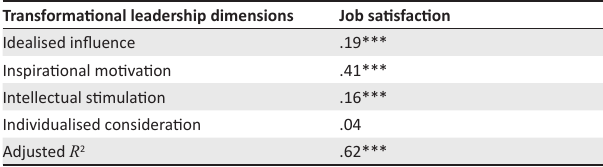
TABLE 4: Linear regression analysis estimates for transformational leadership dimensions and job satisfaction.